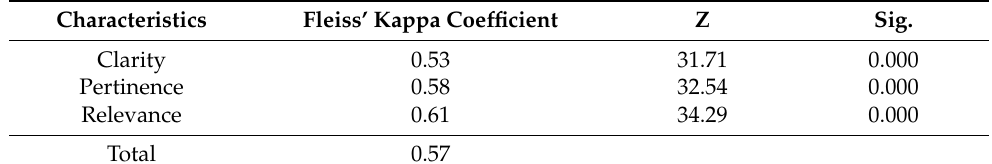
Table 4. Fleiss’ kappa coefficient and statistical significance of the characteristics of the original instrument.